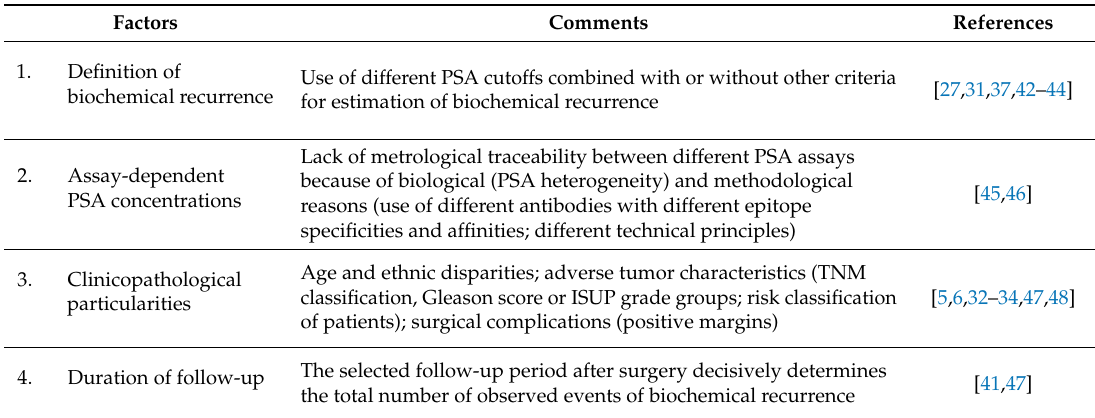
Table 1. Factors influencing the “biochemical recurrence” diagnosis after radical